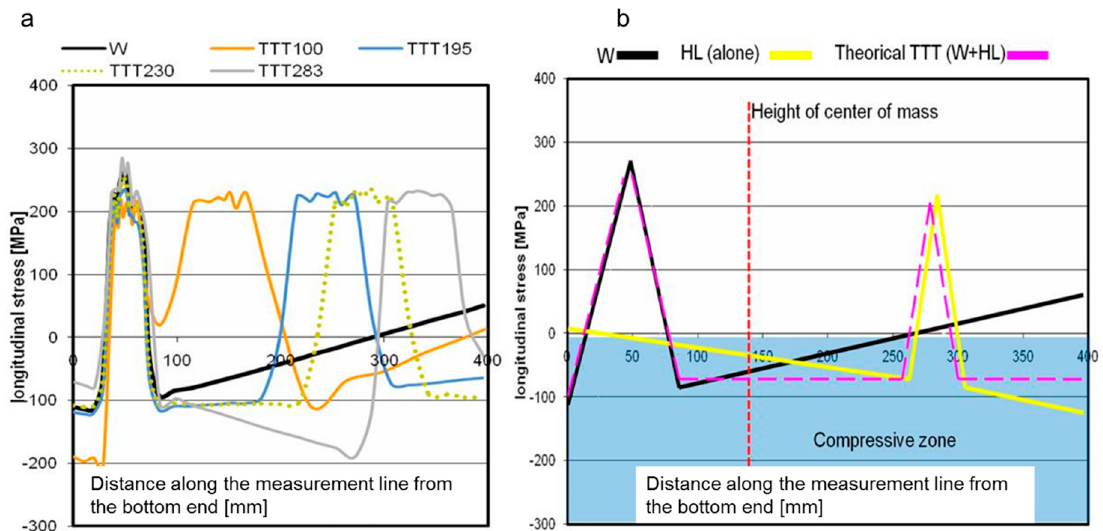
Figure 8. ( a ) Longitudinal residual stresses for different locations of the additional heat source (Figure 3a); ( b ) schematic superposition of residual stresses from FCAW welding and an additional heat source.